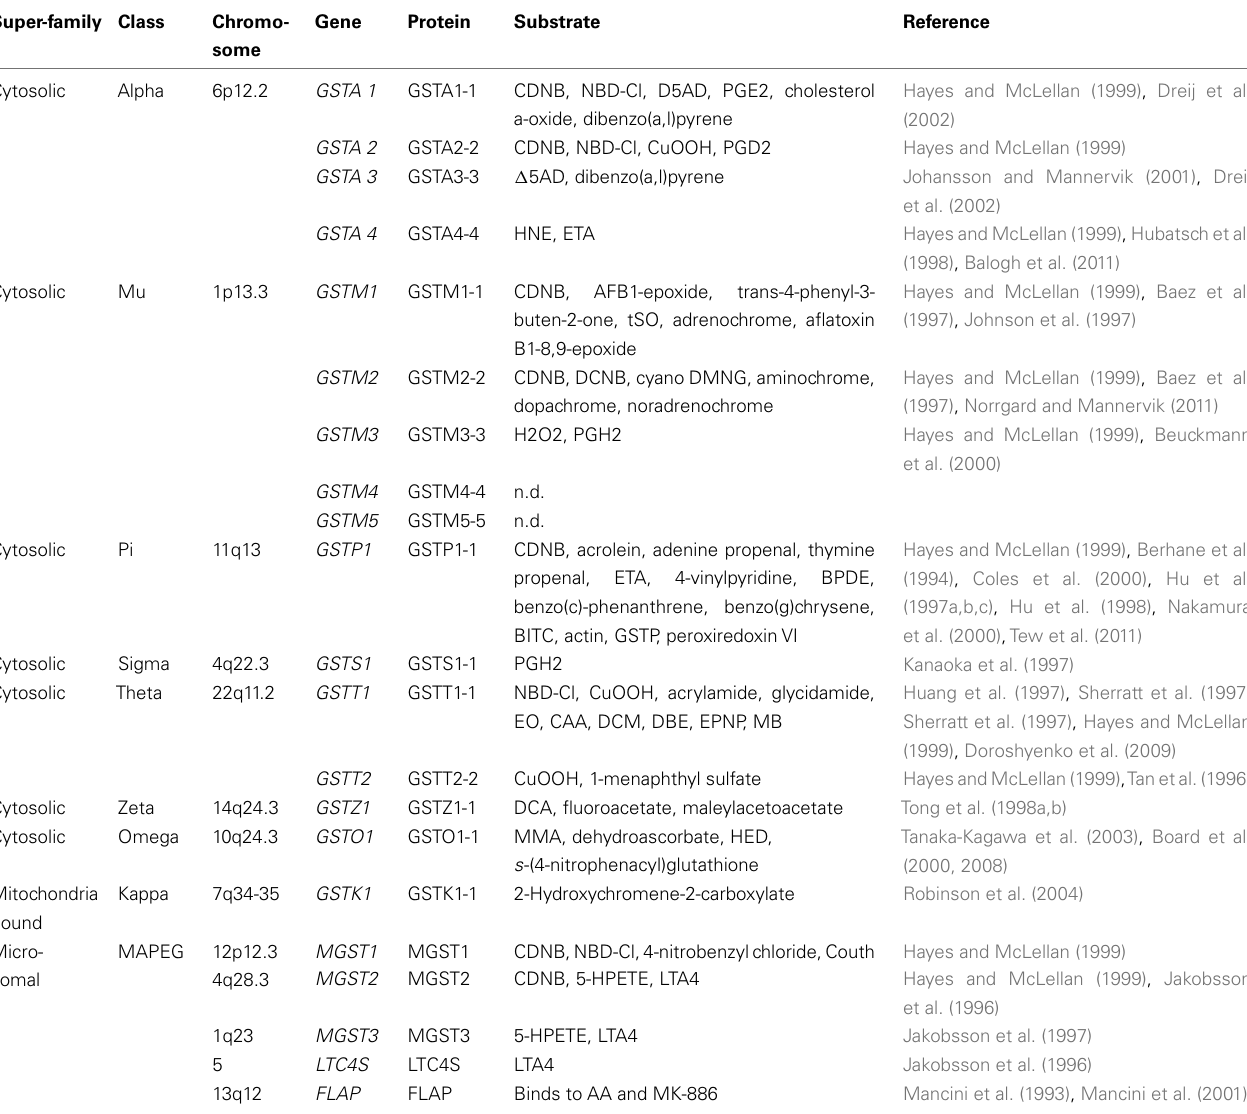
Table 1 | Human GSTs and their biochemical